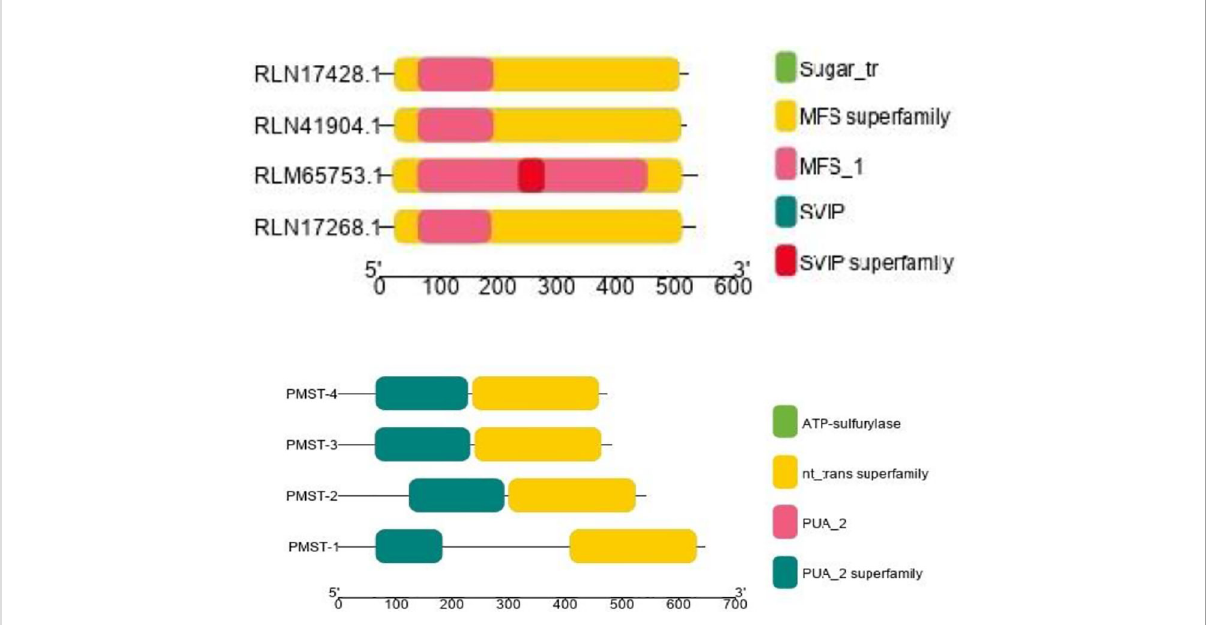
FIGURE 3 CDD of Selenite and selenate transporters in Proso millet respectively. PMST 1-4 represents RLM65282.1, RLN42222.1, RLN18407.1 and RLM74477.1 and PMPT 1-4 represents RLN41904.1, RLN17428.1, RLN17268.1 and RLM65753.1.